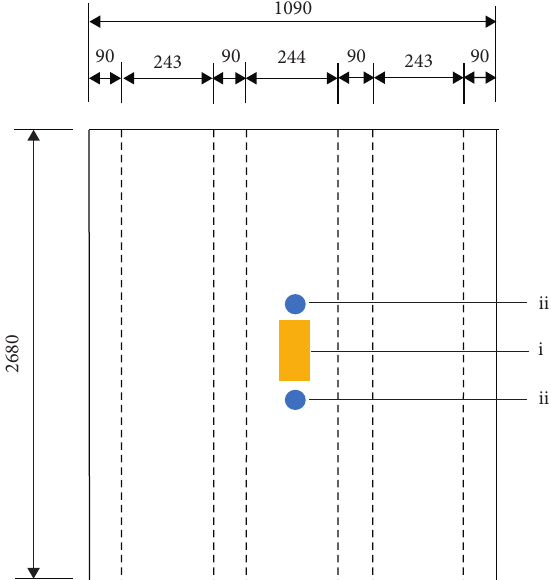
Figure 8: Arrangement of monitoring points on the east wall. (i) Heat flux meter; (ii) T-type thermocouple. Note: the dotted line is the location of the composite